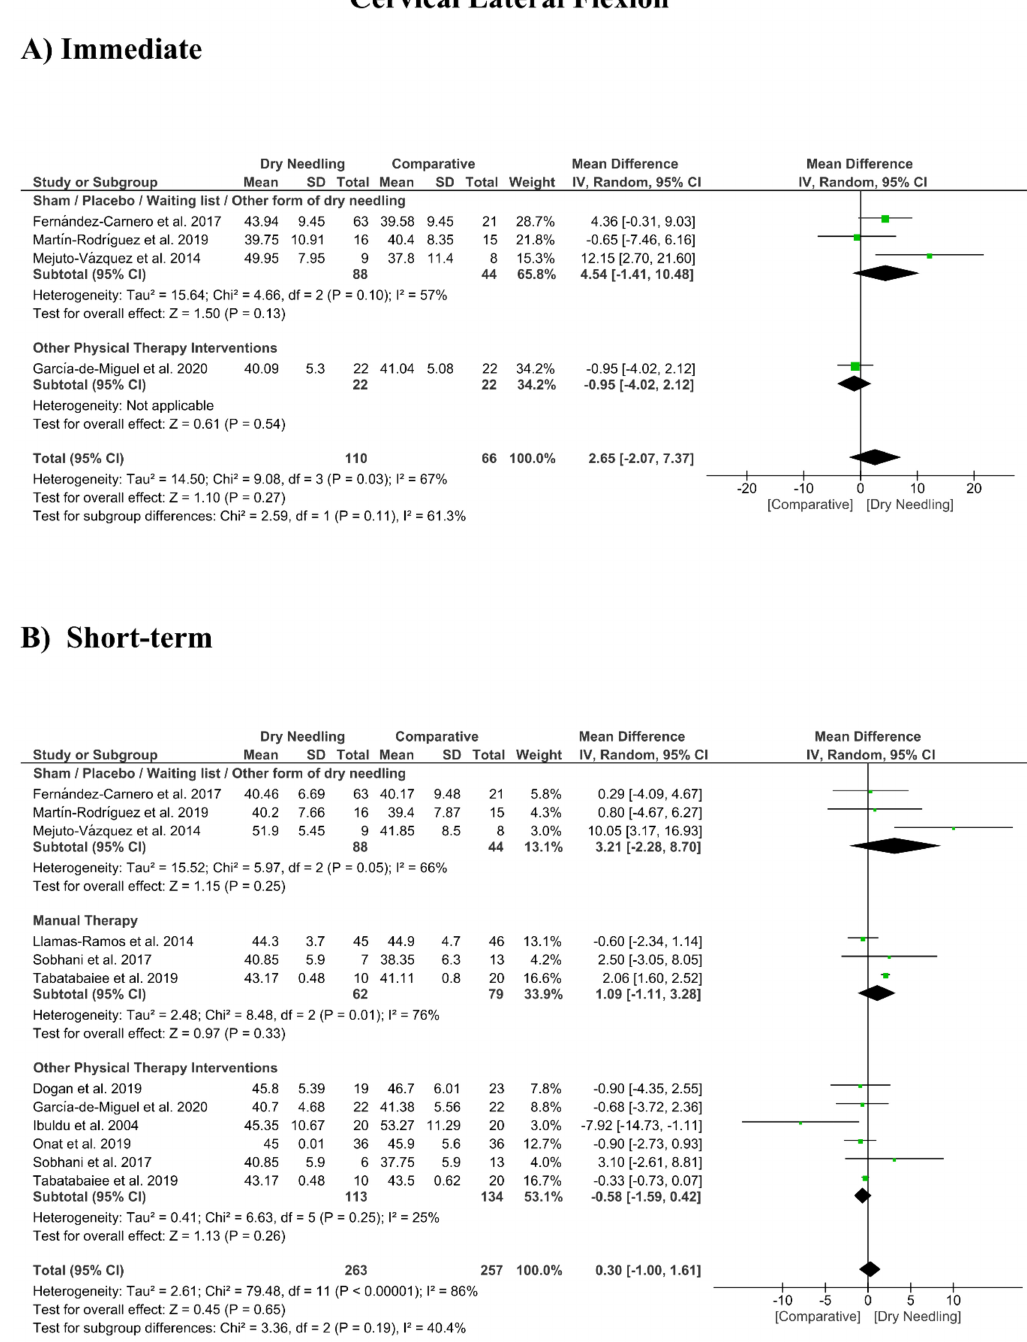
Figure 11. Mean di ff erences (MD) comparing the e ff ects of dry needling alone against sham / placebo / waiting list / other forms of dry needling or manual therapy or other physical therapy interventions on the cervical range of motion in lateral-flexion ( A ) immediately after and ( B ) at the short-term. SD: standard deviation; CI: confidence